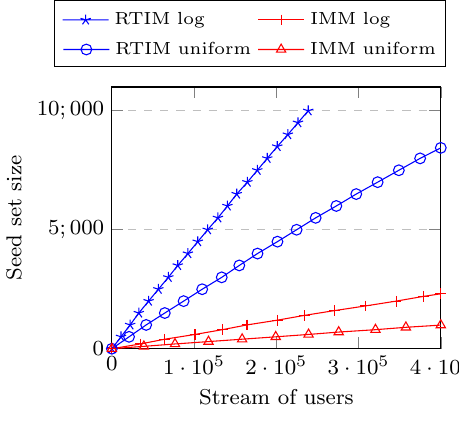
Fig. 6 LiveJournal ’s seed set size evolution